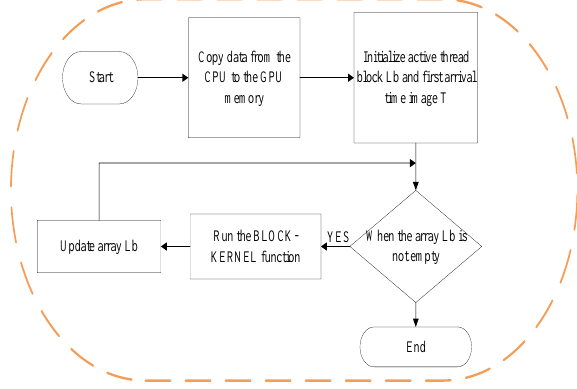
Figure 2. Algorithm flow based on thread block iteration Algorithm Description ： The algorithm consists of